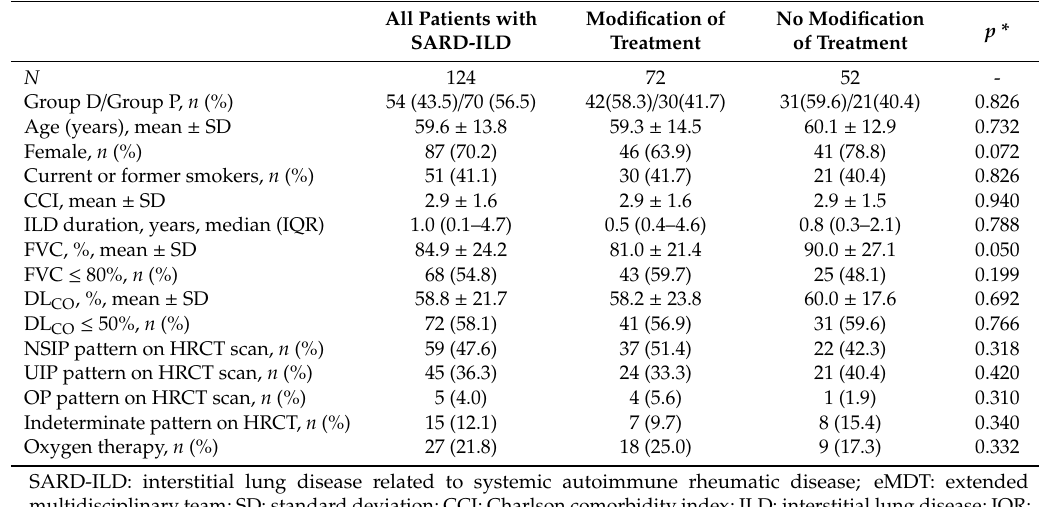
Table 3. Characteristics of patients with SARD-ILD evaluated at eMDT according to the final decision on treatment.